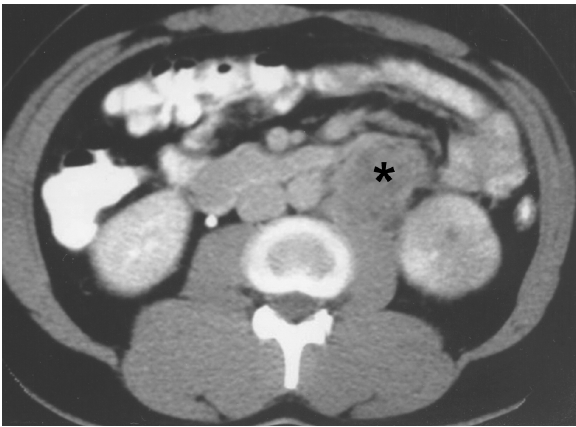
Figure 1 – Abdominal computed tomography illustrating retro- peritoneal mass pre chemotherapy (asterisk). Initial stage